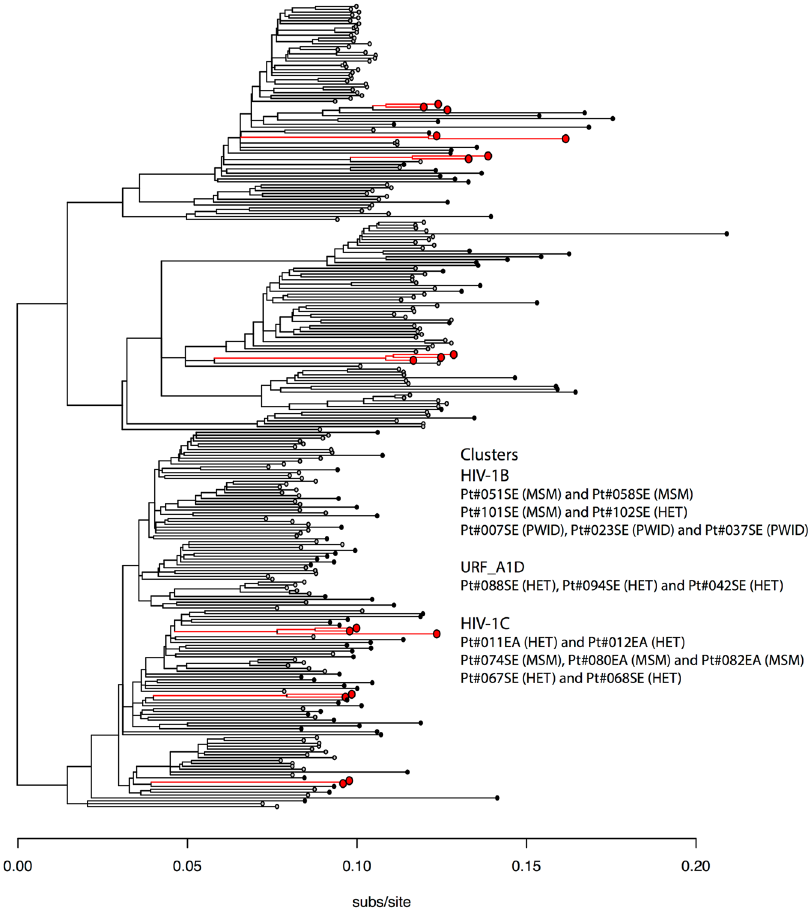
Figure 3. The evolutionary relationships based on HIV-NFLG using family-joining. Transmission clusters (n = 7) were constructed for trees at a threshold of 0·08 substitutions per site and are indicated within the figure with red colour. SE: patient reported to have been infected in Sweden; EA: patient reported to have been infected in East Africa. MSM: men who have sex with men; HET: patient self-reported to have been infected heterosexually; PWID: patient with intravenous drug